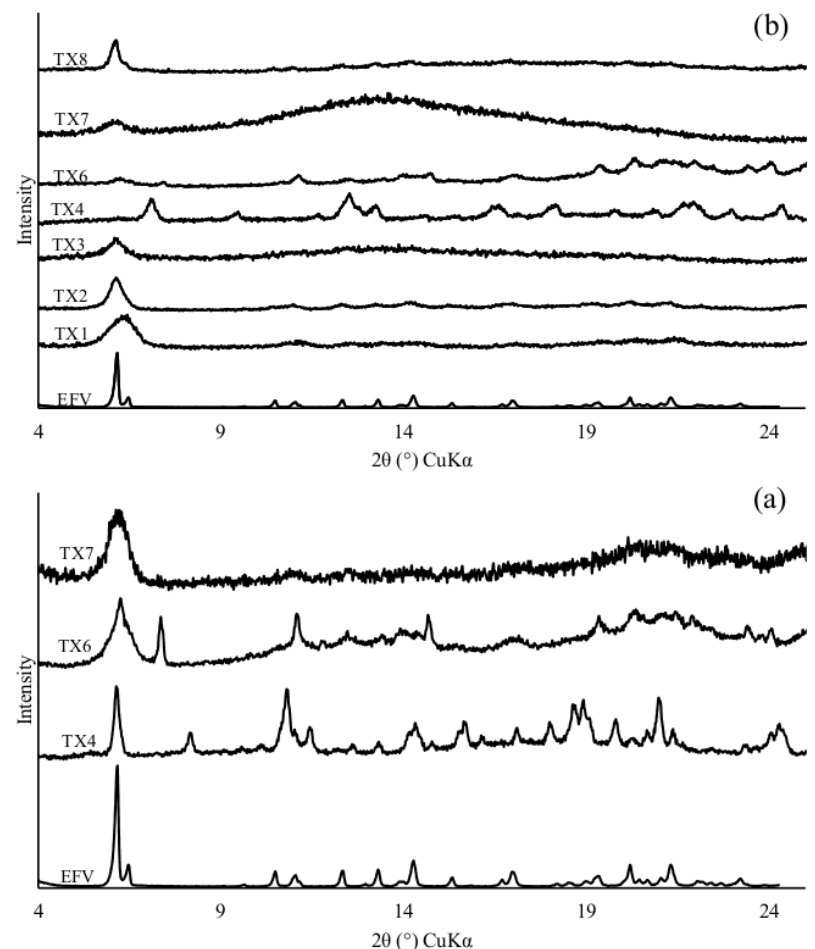
FIGURE 4 - (a) Diffraction patterns using step time of 0.01 seconds; (b) Diffraction patterns using step time of 0.5 seconds. Comparison of diffraction patterns of samples with efavirenz (EFV), showing the presence of peaks relative to efavirenz polymorph